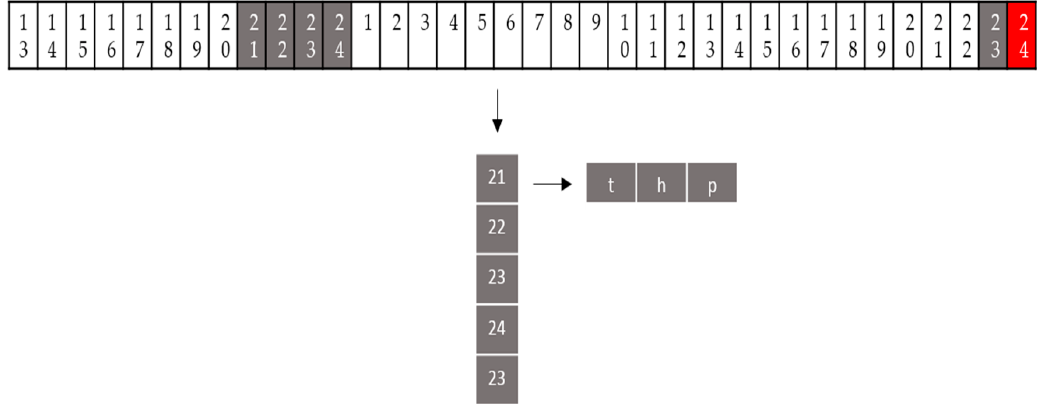
Figure 5. The first type of input data format ( G1 ) represented by a timeline, where each data contains three values: temperature t, humidity h, and pressure